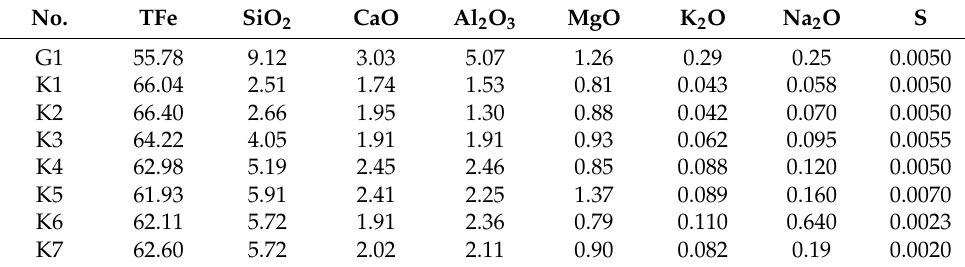
Table 1. Chemical compositions of the deposit samples (wt%) [27].